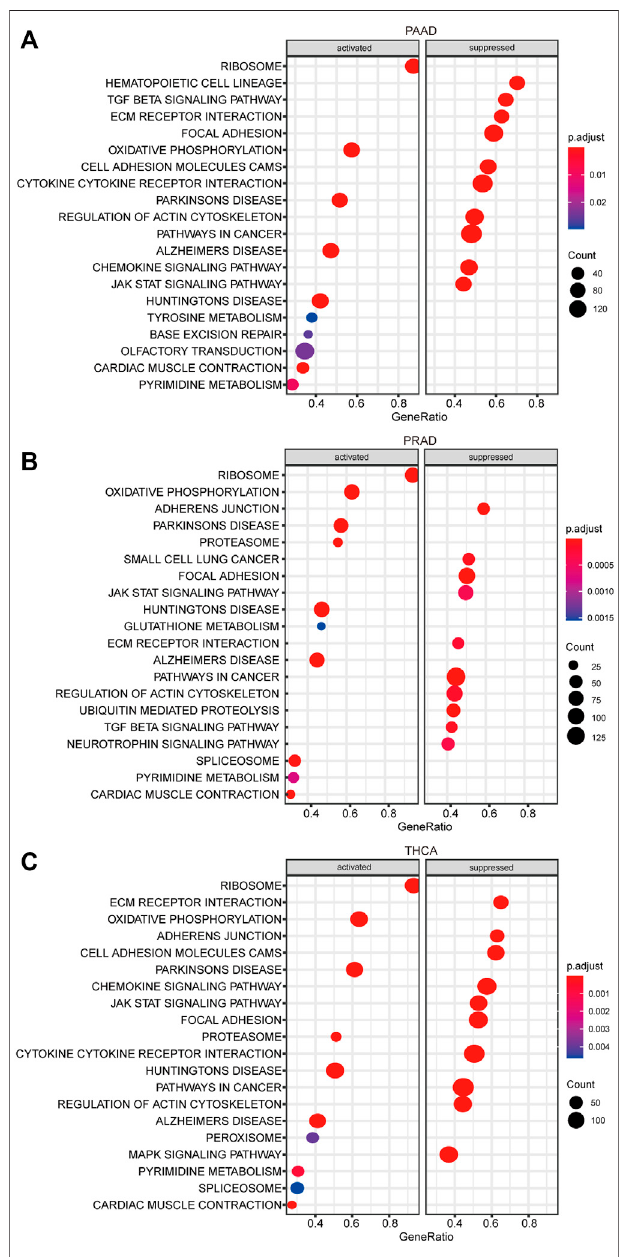
FIGURE 12 | KEGG enrichment analysis of ALKBH7. (A) Top 20 enriched KEGG pathways in PAAD. (B) Top 20 enriched KEGG pathways in PRAD. (C) Top 20 enriched KEGG pathways in